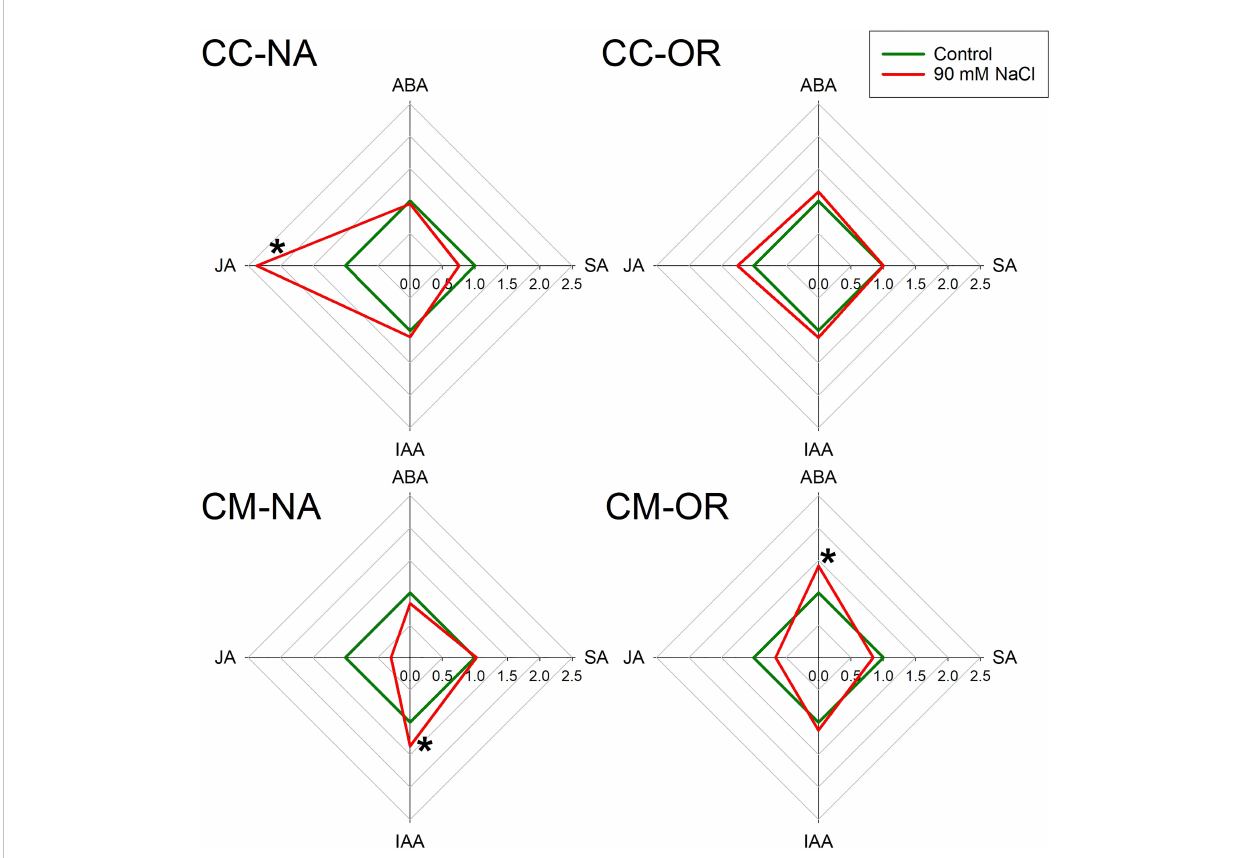
FIGURE 5 Leaf phytohormone content. Radar plots with leaf relative content of abscisic acid (ABA), jasmonic acid (JA), salicylic acid (SA), and indole acetic acid (IAA) in control (green lines), and 90 mM NaCl stressed plants (red lines) of CC-NA, CC-OR, CM-NA, and CM-OR after 30 days. Data are mean of three replicates. Asterisks denote statistically signi fi cant differences between control and salt-stressed plants of each scion/rootstock combination at p ≤